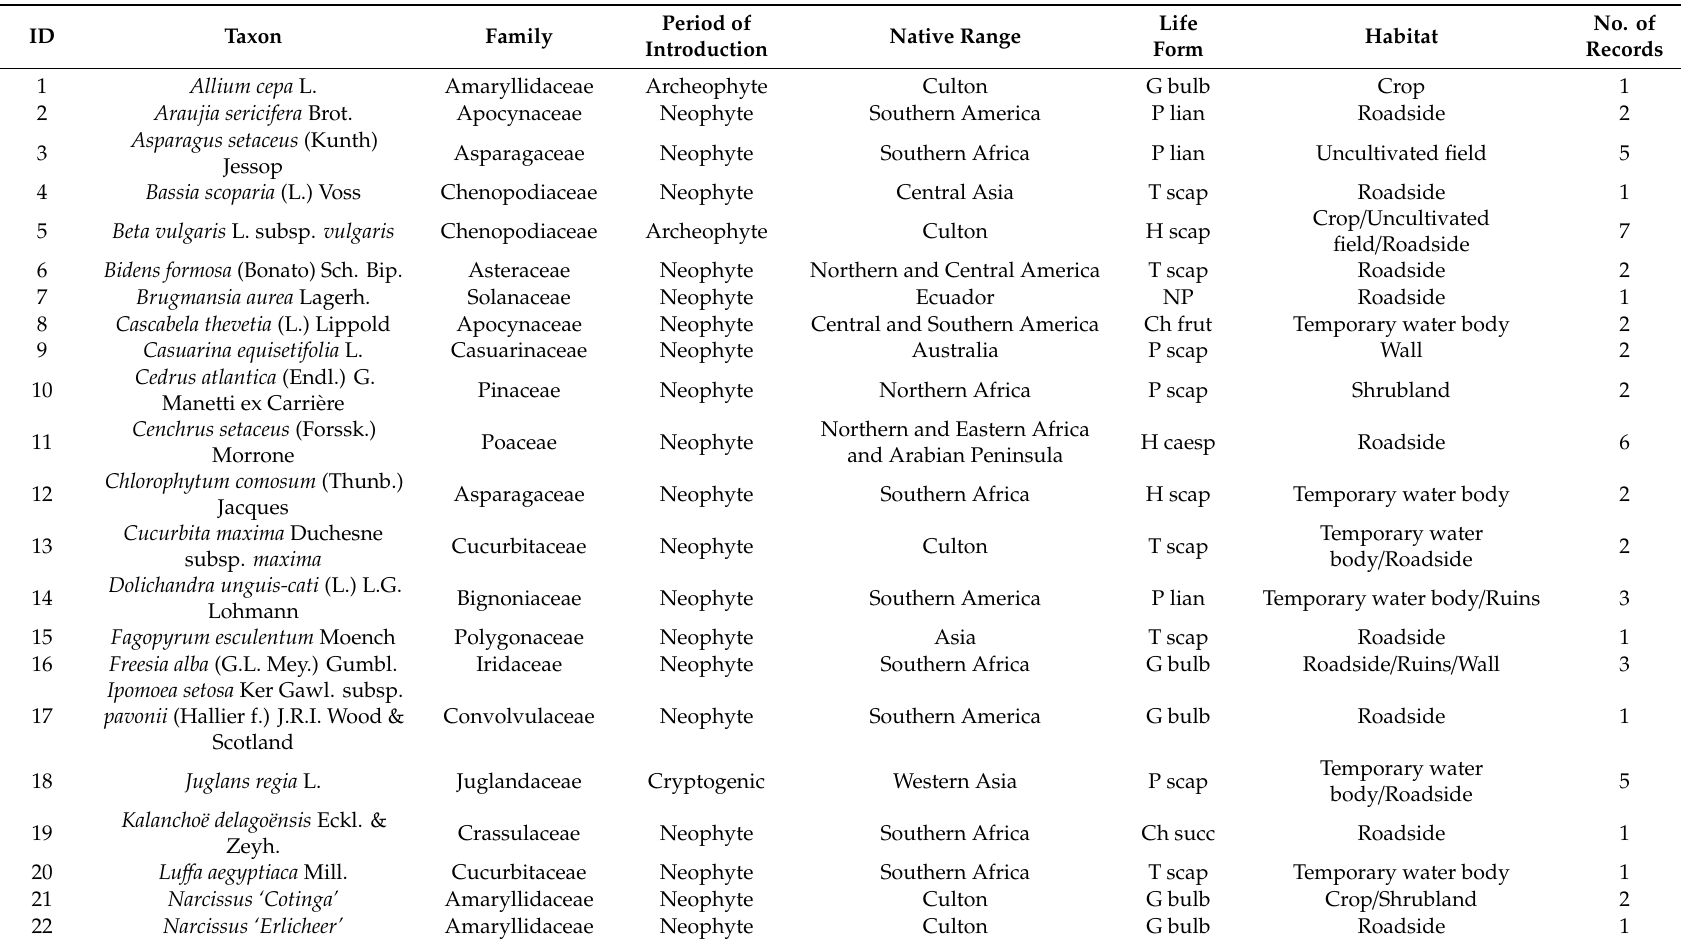
Table 2. Detailed list of the 34 alien taxa recorded to Calabria (Southern Italy, Europe) including family, period of introduction, native range, life form, habitat, and number (No.) of records for each